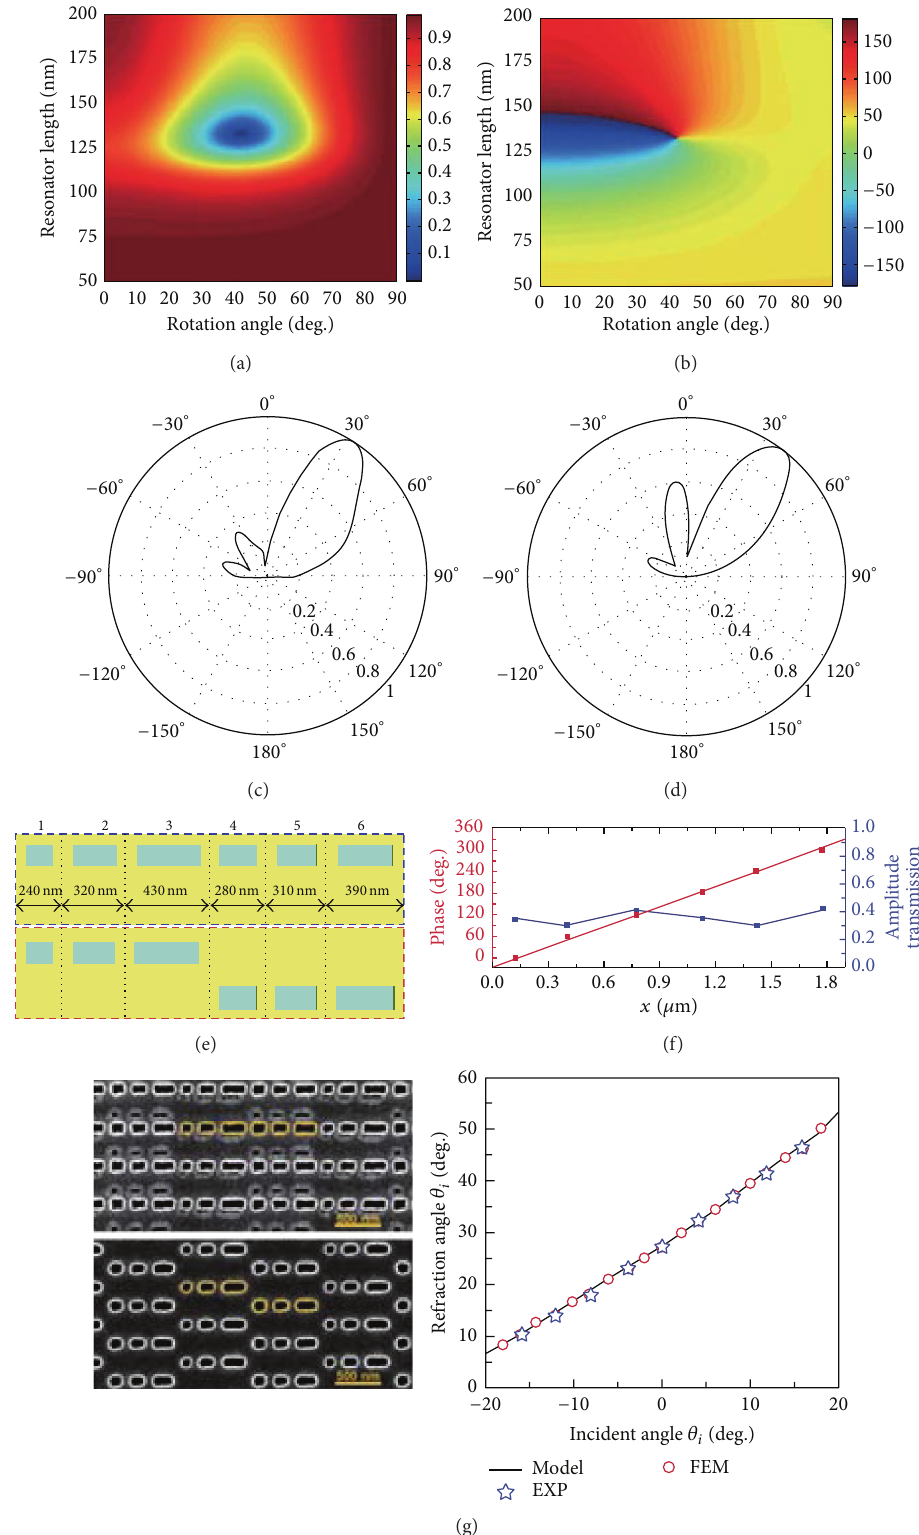
Figure 38: (a) Magnitude and (b) phase of 𝑆 11 in degrees for different resonator lengths and rotation angles. (c, d) Radiation patterns of (a) Dolph-Tschebyscheff and (b) uniform arrays. Both arrays redirect the normally incident plane wave at 33 ∘ . (e) Schematics of the top and bottom nanoapertures forming the super-unit-cell in the plasmonic metasurfaces for the demonstration of anomalous refraction. (f) The transmission phase and amplitude of each nanoaperture pair, calculated under 𝑦 -polarized incident light at 900nm. (g) SEM image of the sample (left panel) and measured refraction angle (right panel). Figures are reproduced from [181,